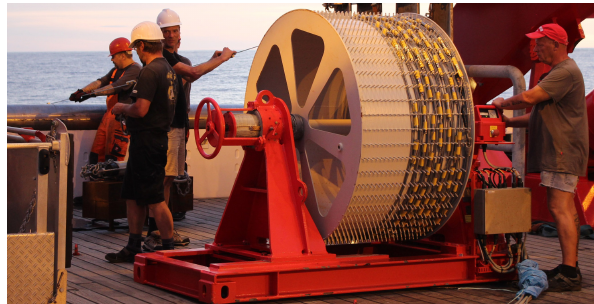
Figure A1. Photo of thermistor string deployment using the instru- mented cable spooling drum onboard R/V Sonne